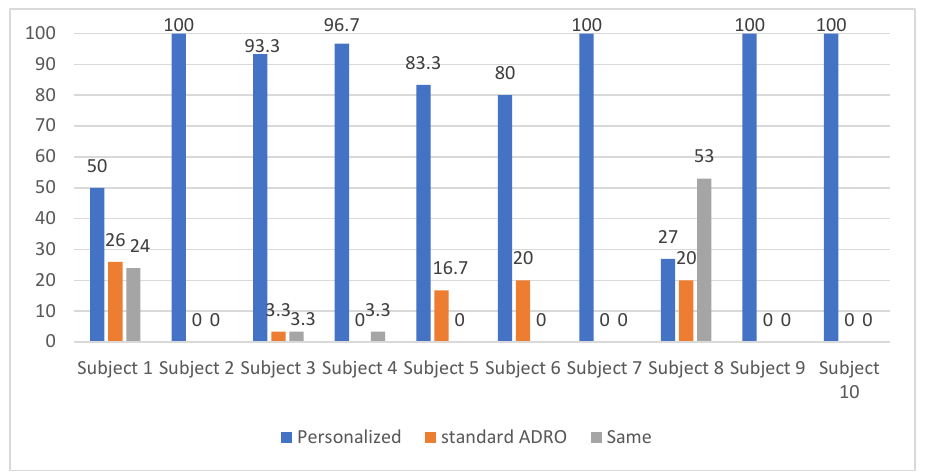
Figure 8. Comparison of the preference percentages between the standard ADRO and the personalized ADRO.